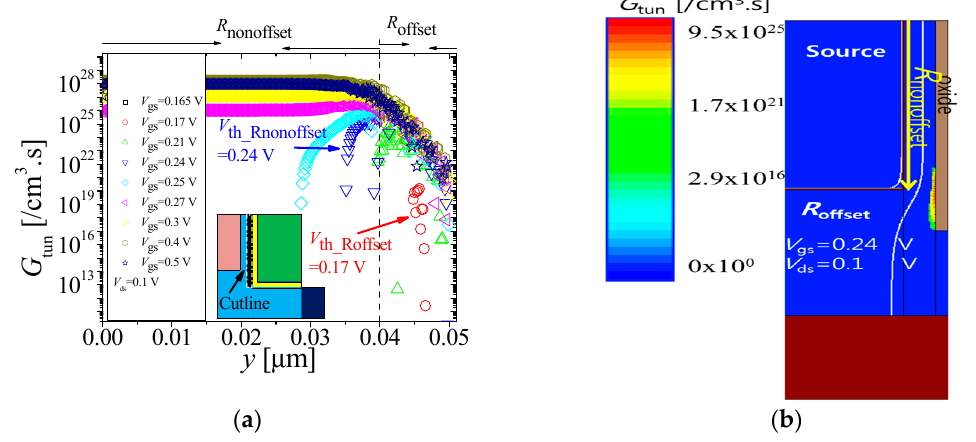
Figure 4. ( a ) G tun at different V gs . ( a ) V th_Rnonoffset = 0.24 V and V th_Roffset = 0.17 V. ( b ) G tun contour plot at V gs = V th_Rnonoverlap = 0.24 V. In ( b ), yellow arrow indicates the height of R nonoffset .